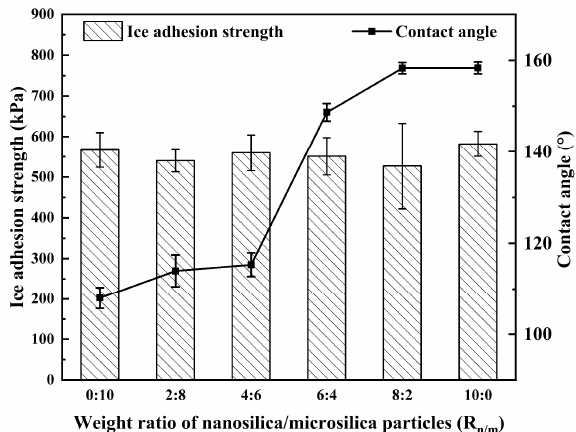
Figure 6. Ice adhesion strength ( τ ice ) and CA of nano / microsilica-filled A-PDMS-modified epoxy coating on various R n / m . The error bar is one standard deviation.